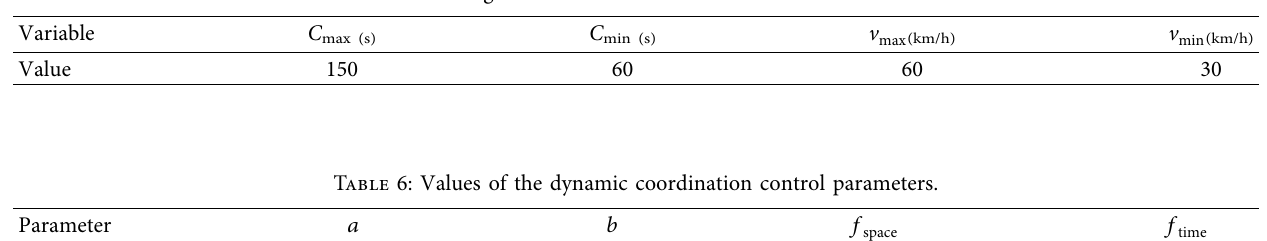
Table 5: Value of the green wave coordinated control variable in the subarea.